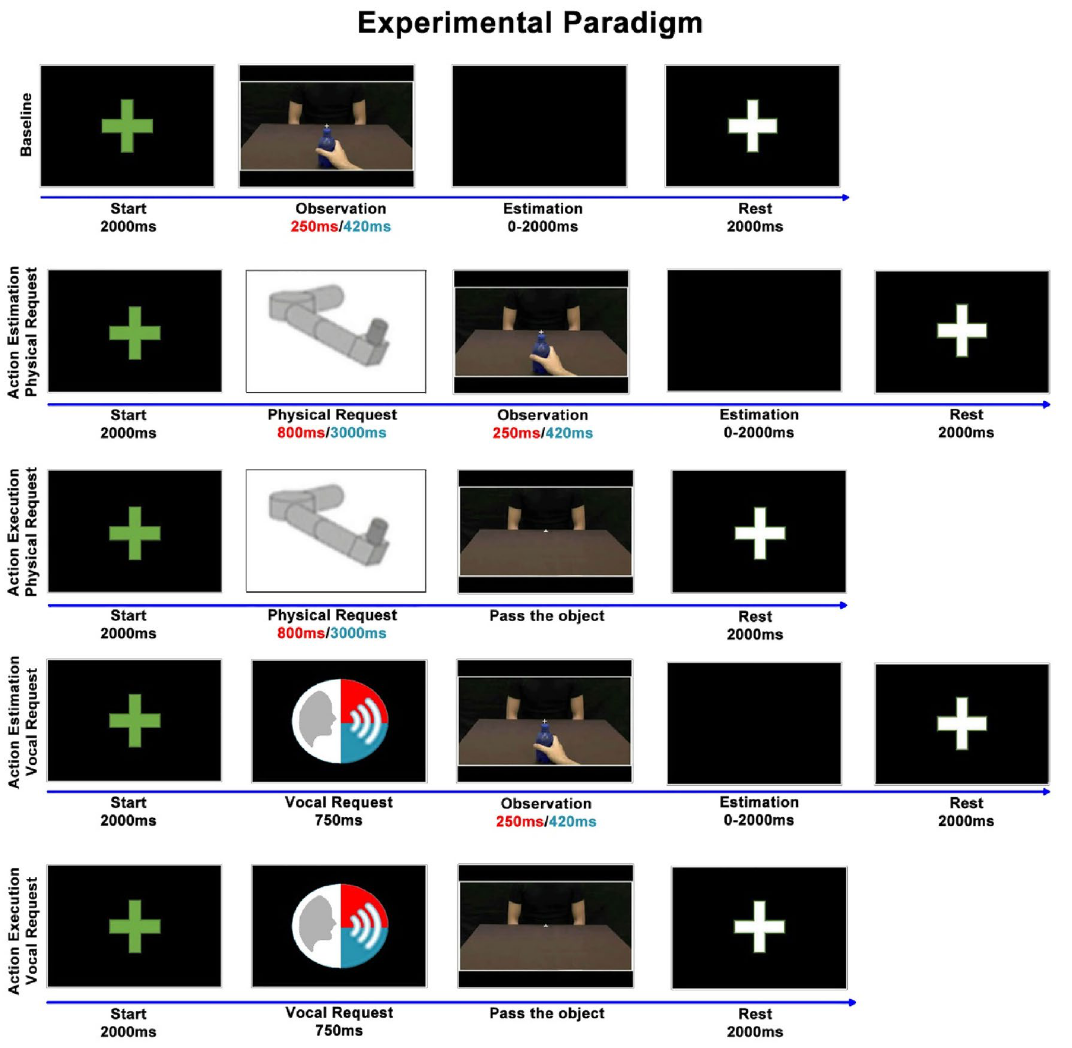
Figure 2. Experimental paradigm. For each run, the green fixation cross (Start, 2000 ms) indicated the beginning of a new trial. In the Baseline run and in the two Estimation runs (2nd and 4th rows) participants observed the initial part of the action (Observation), then the monitor turned black (Estimation, 0–2000 ms), and when they pressed the button on the handle to estimate the action conclusion a white fixation cross appeared (Rest, 2000 ms). In the two Action runs (3rd and 5th rows), when a static image of an actor/actress appeared (Pass the object), participants moved actively the handle in front of them. At the end of the passage, the manipulandum moved passively the arm at the starting position and the white fixation cross appeared (Rest, 2000 ms). The panel with the manipulandum icon (Physical Request) indicated that a physical request preceded the subsequent task. The panel with the audio icon indicated that a vocal request preceded the subsequent task. Red color corresponds to rude vitality forms while blue color corresponds to gentle vitality